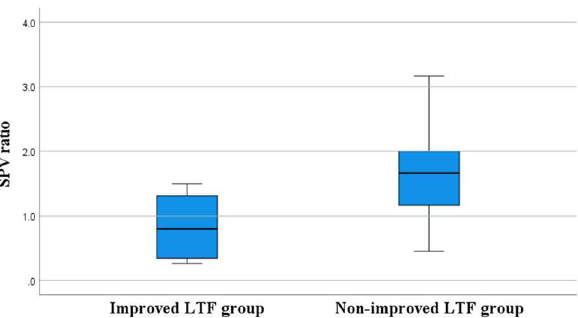
Figure 2. Box and whisker plot showing distribution of the SPV ratios in the improved LTF group and non- improved LTF